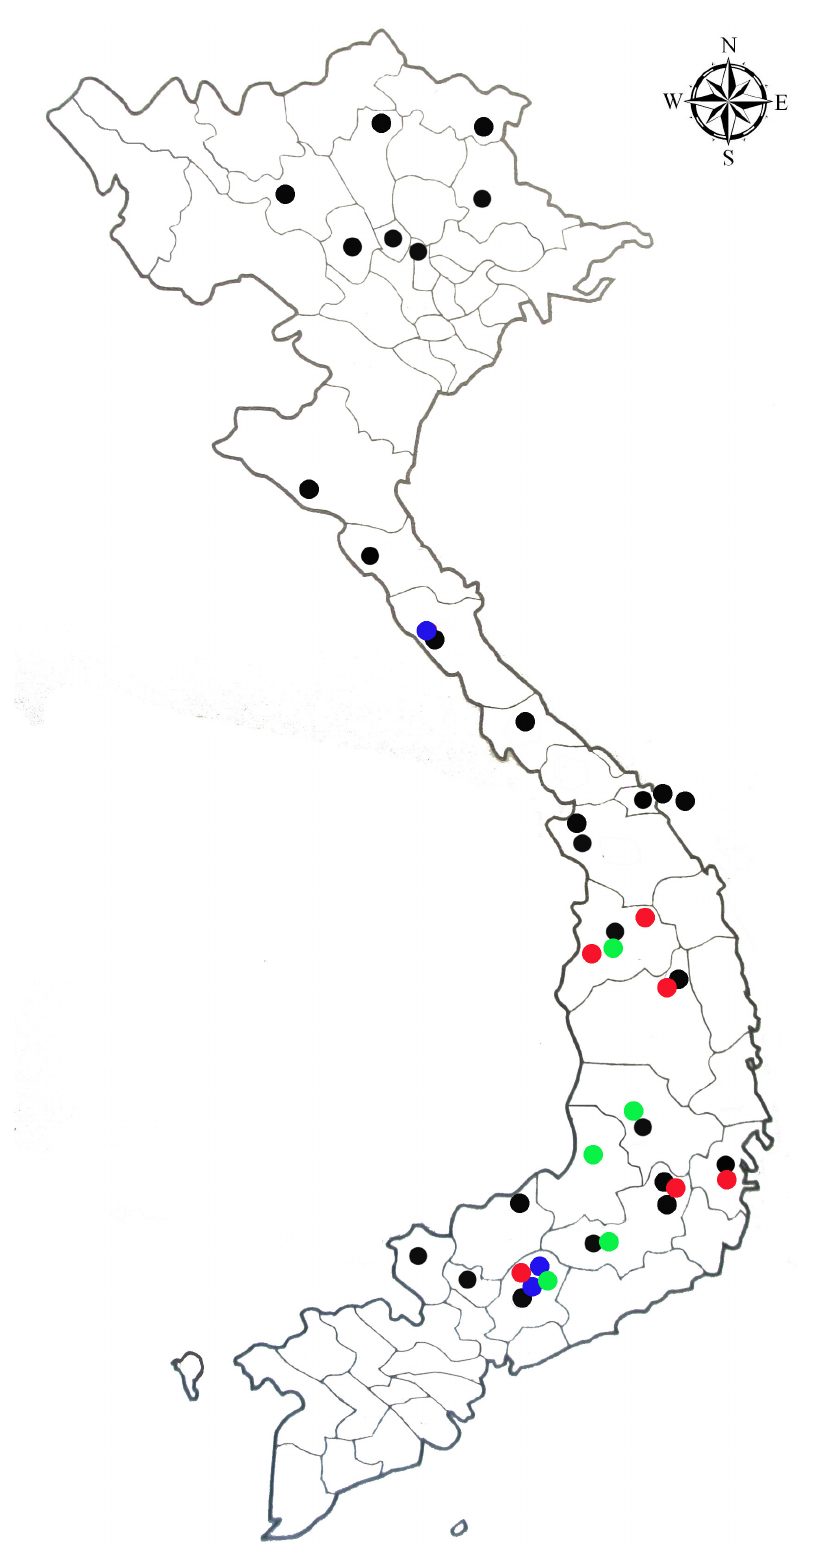
Fig. 17. Distribution map of Prodasineura Cowley, 1934 spp. in Vietnam (blue group species including the blackish P. autumnalis (Fraser, 1922)). (●) P. autumnalis . (●) P. coerulescens (Fraser, 1932). (●) P. doisuthepensis Hoess, 2007. (●) P. hoffmanni Kosterin,